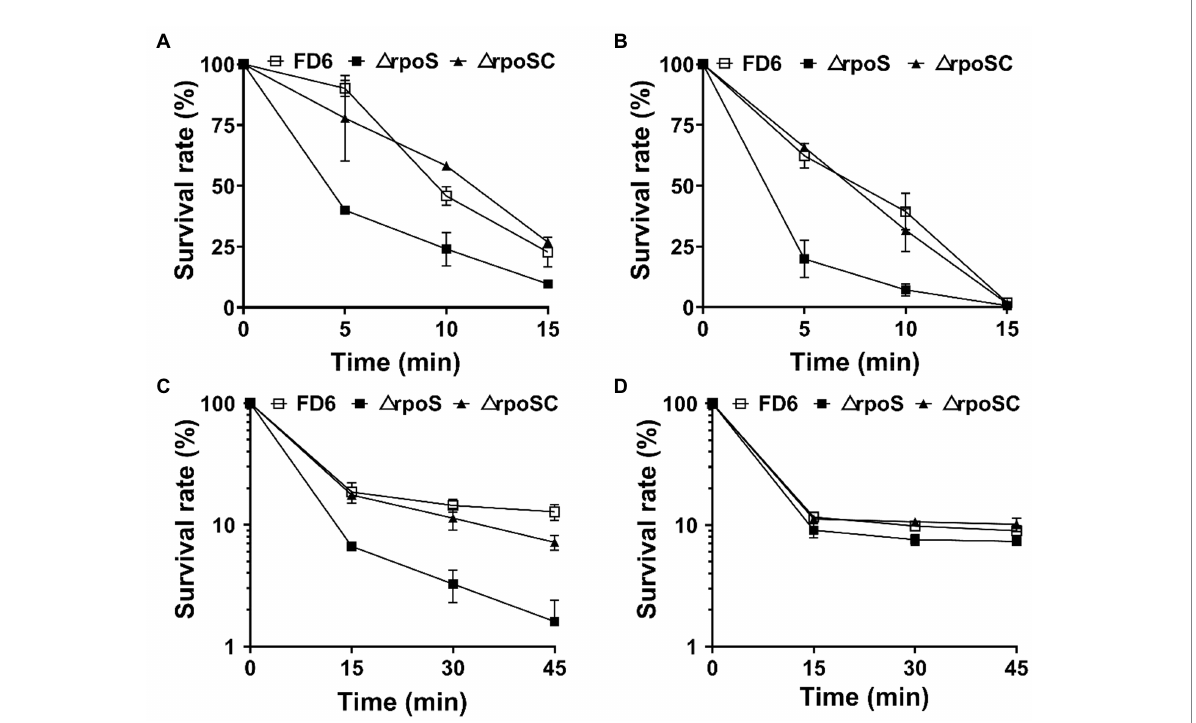
FIGURE 1 Roles of rpoS in resistance to (A) heat, (B) 12% ethanol, (C) 5 M H 2 O 2 or (D) 2.4 M NaCl. Cultures of Pseudomonas protegens FD6 strains were exposed to different stress conditions. The bacterial cells were resuspended in sterilized M9 liquid medium to test cell viability. The experiment was carried out in three biological replicates. Error bars represent ±standard